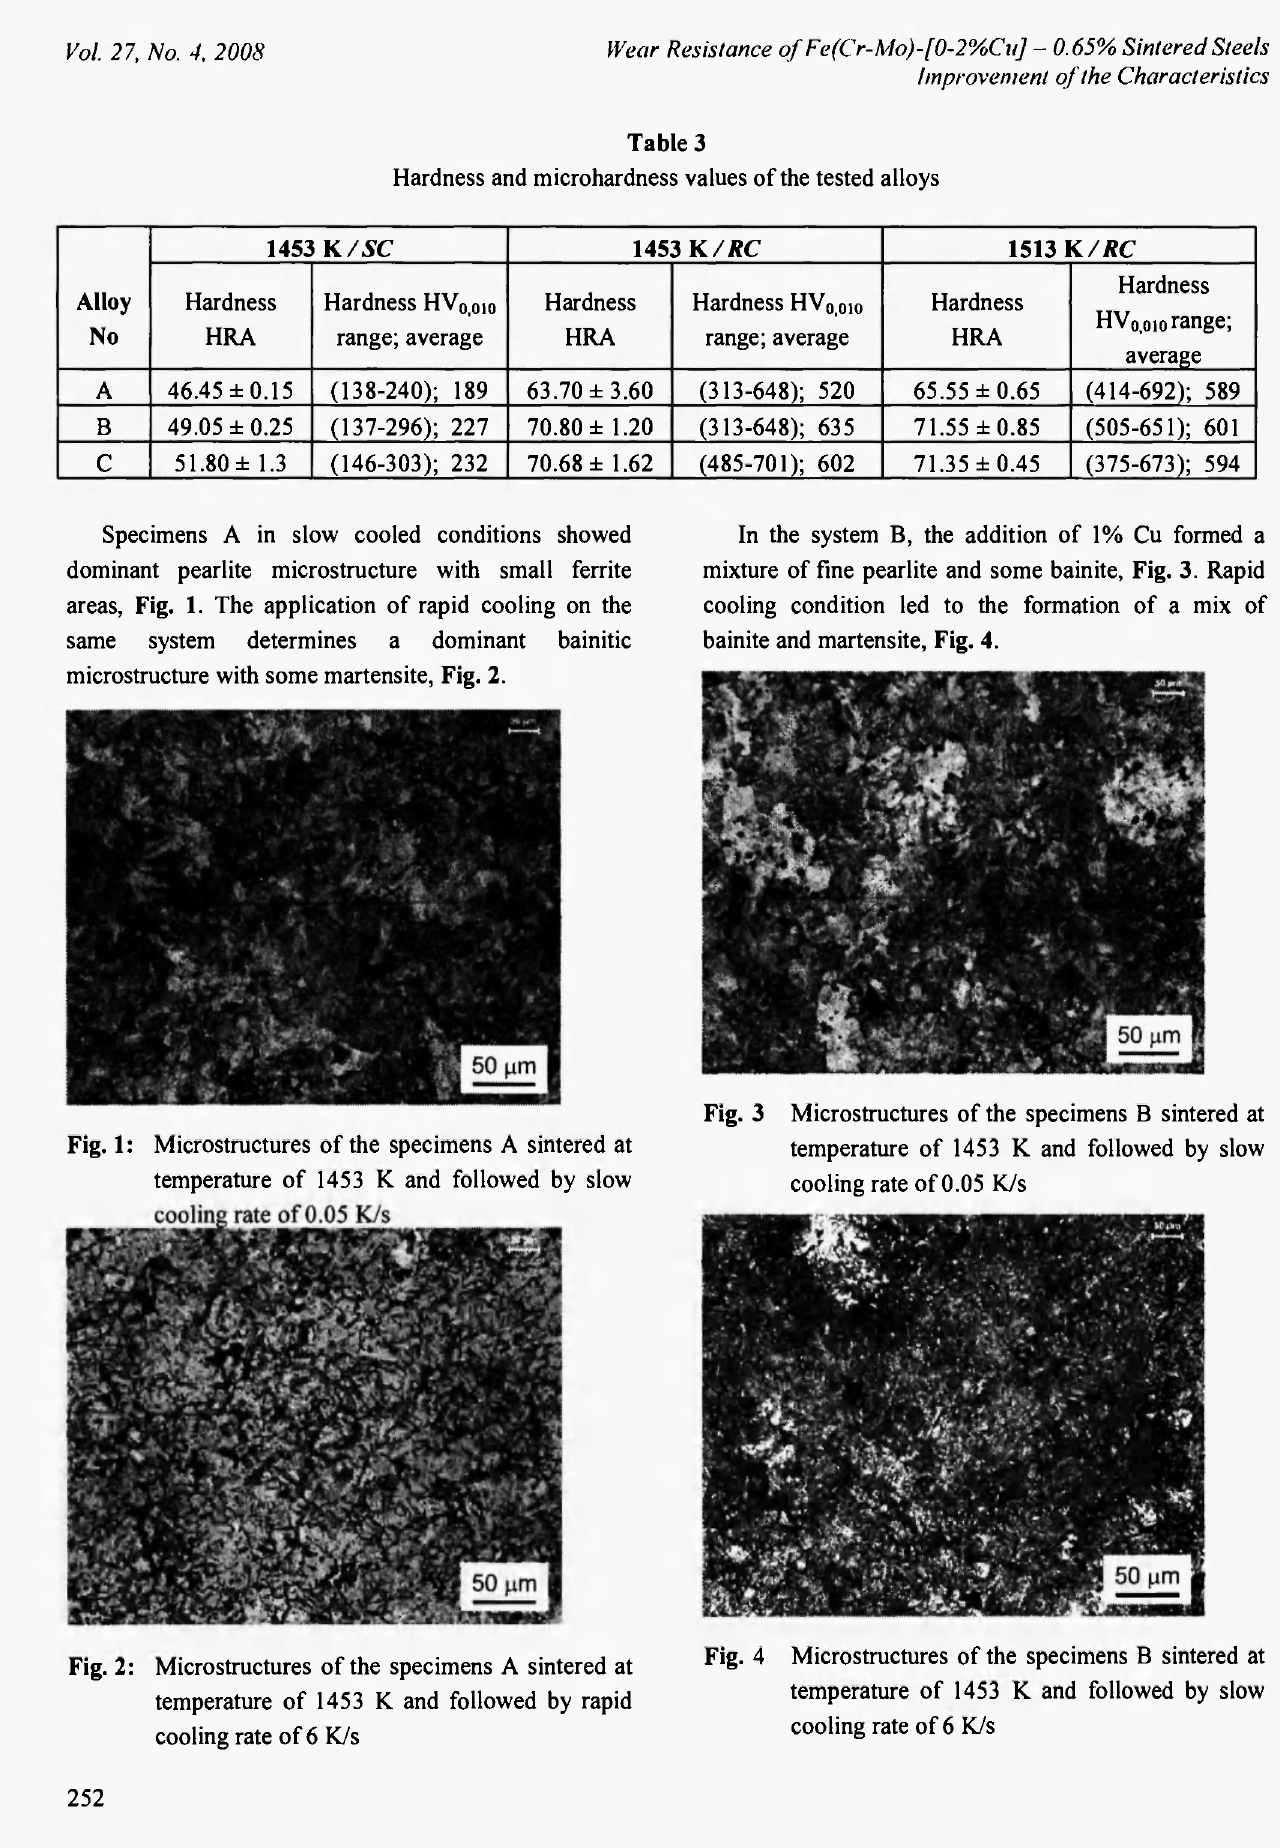
Fig. 4 Microstructures of the specimens Β sintered at temperature of 1453 Κ and followed by slow cooling rate of 6